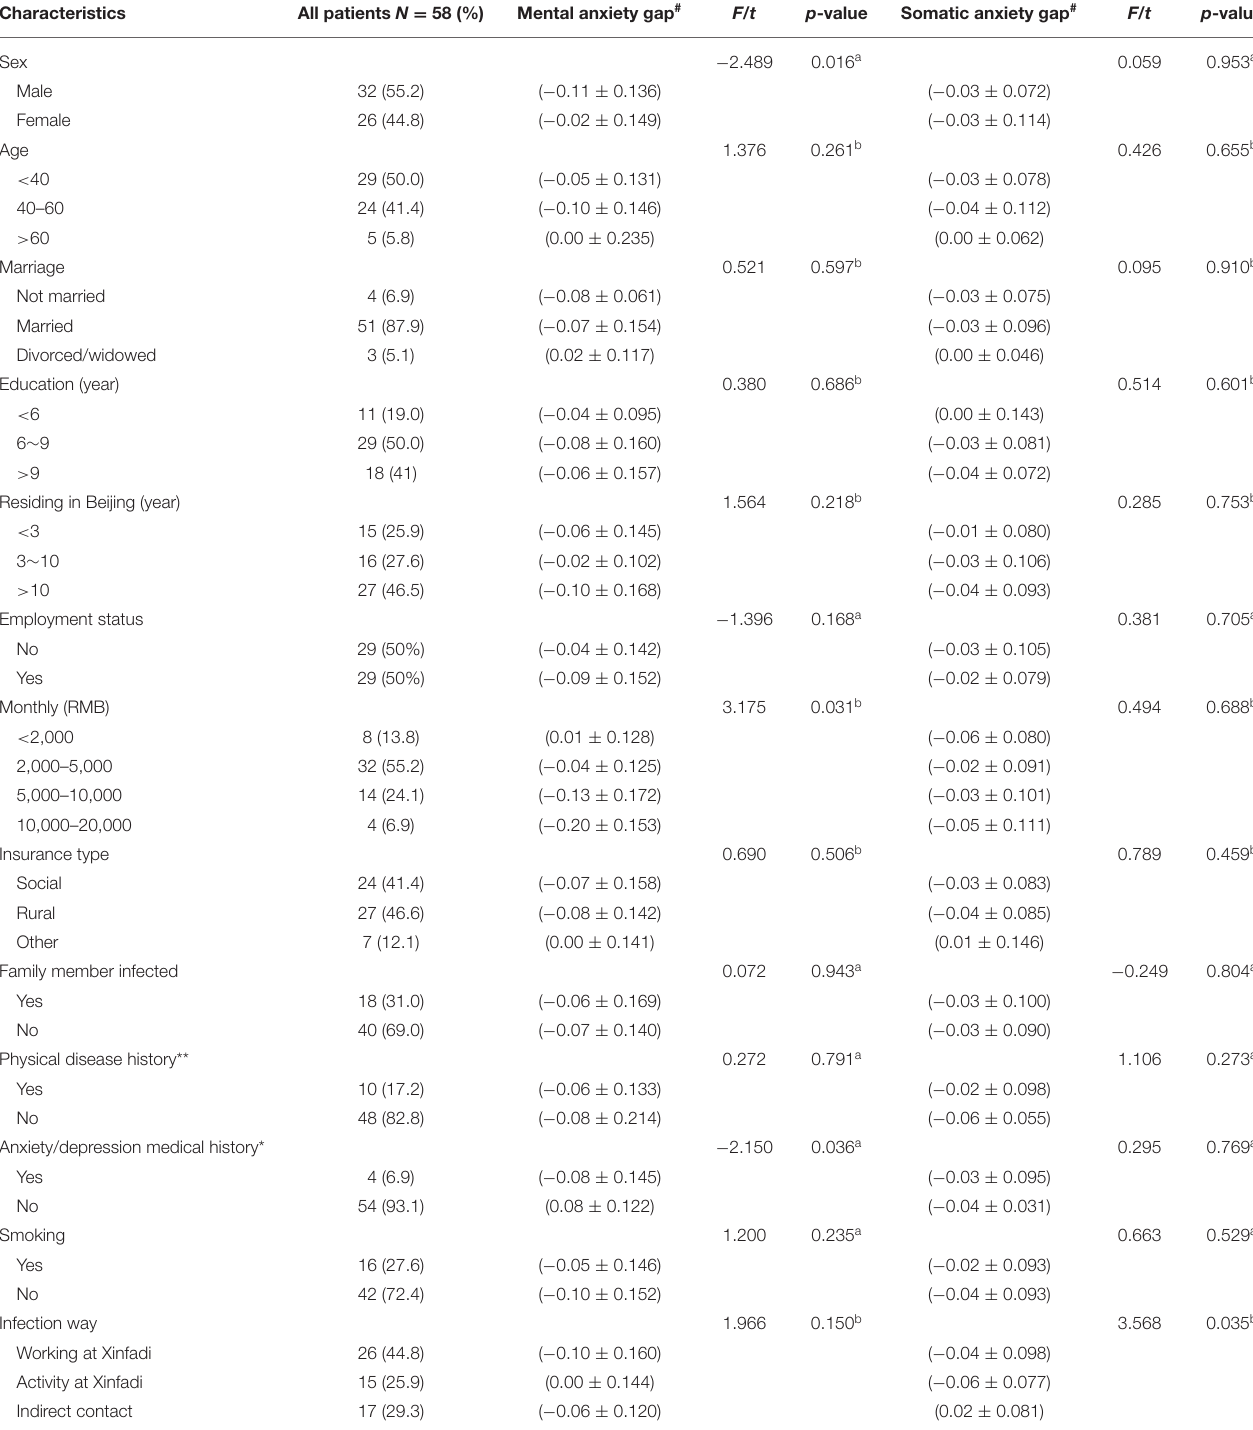
TABLE 1 | Gaps of SAS and HAMA scores among various demographic characteristics.